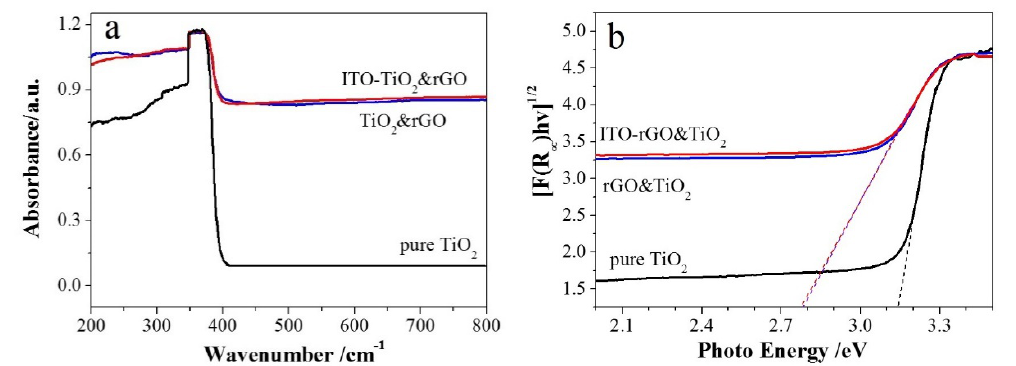
Figure 8. ( a ) UV–vis diffuse reflectance spectra (DRS) of the pure TiO 2 , rGO and TiO 2 , and ITO-rGO and TiO 2 , and ( b ) curve of [F (R ∞ ) h v ] 1 / 2 versus photon energy of pure TiO 2 , rGO and TiO 2 , and and TiO 2 , and ( b ) curve of [F (R ∞ ) h v ] 1/2 versus photon energy of pure TiO 2 , rGO and TiO 2 , and ITO- ITO-rGO and TiO 2 rGO and TiO 2 .